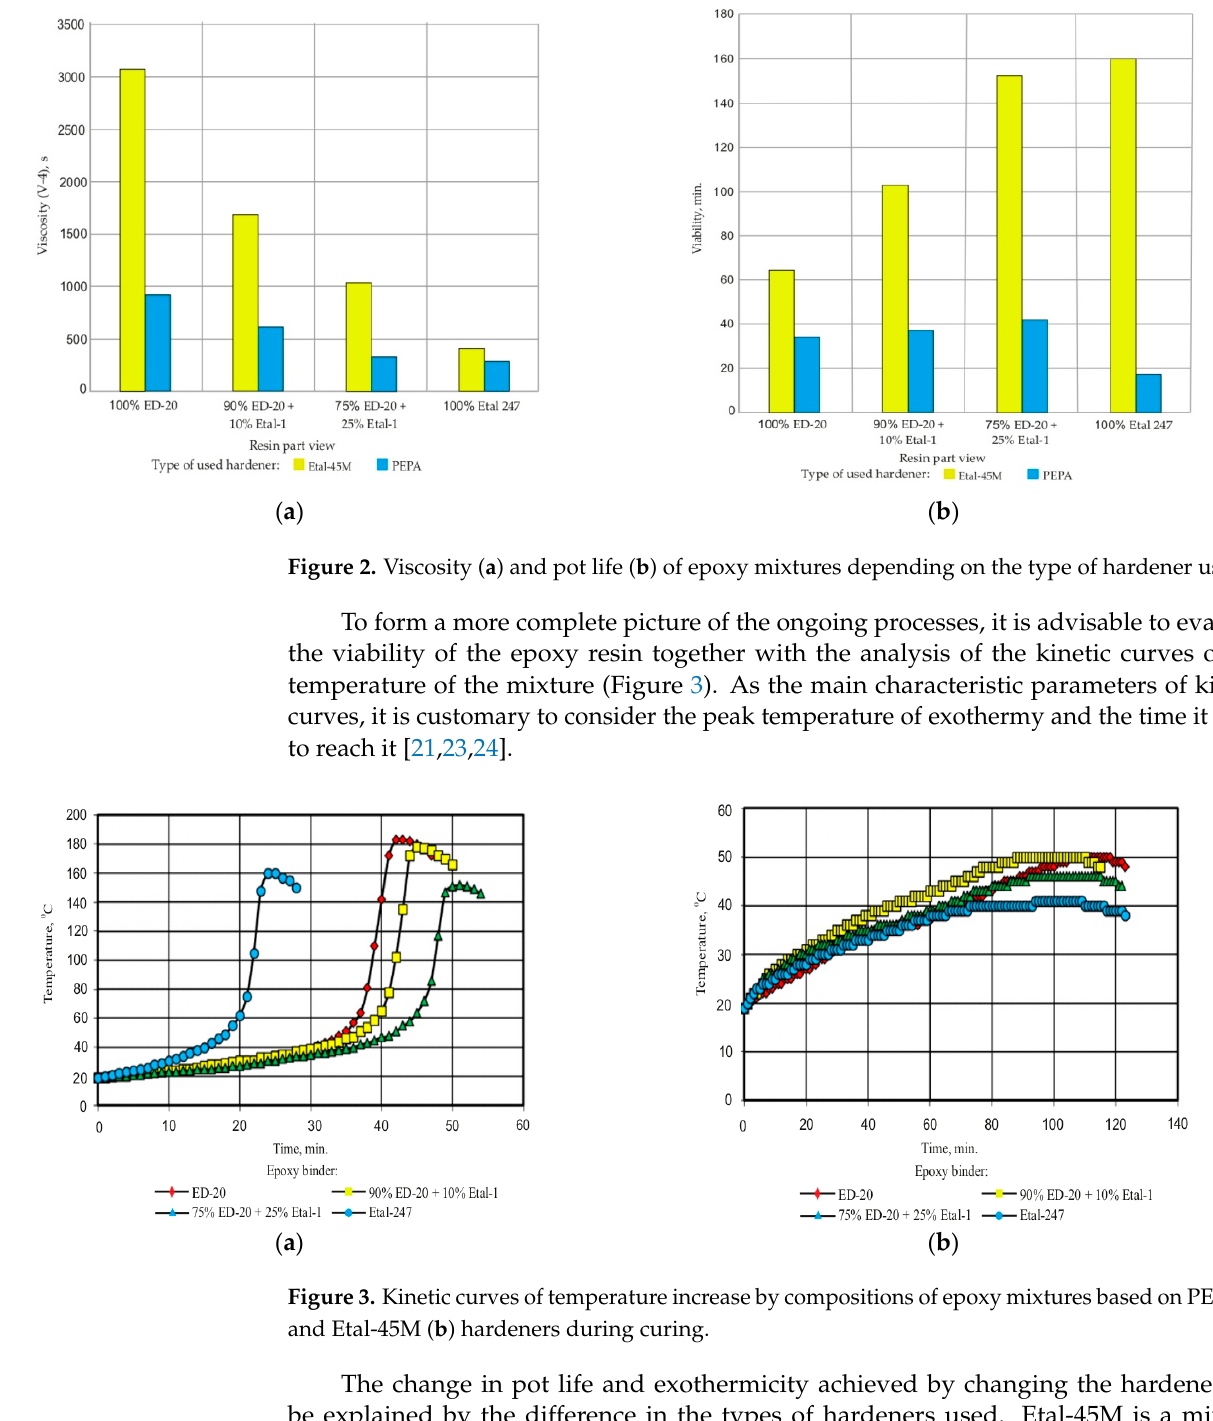
Figure 4. EP tensile strength depending on the brand of hardener used. Table 5. EP strength indicators depending on the type of resin part and hardener. Controlled Indicators Hardener Grade